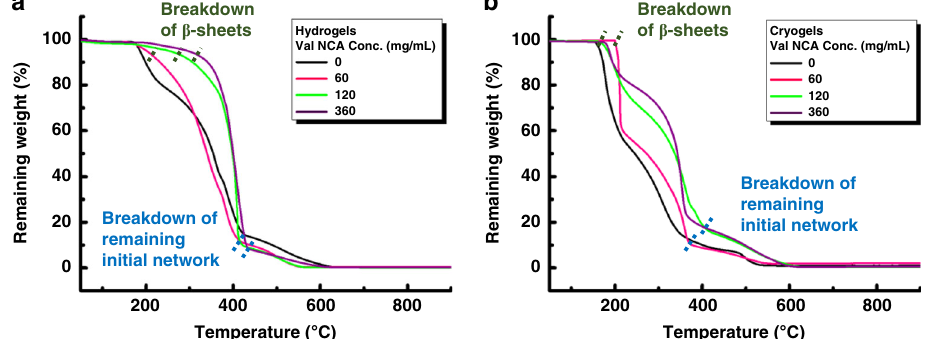
Fig. 7 TGA analysis of the initial and β -sheet incorporated networks. Networks made using different Val NCA concentrations (60, 120, 360 mg/mL): a hydrogels; b